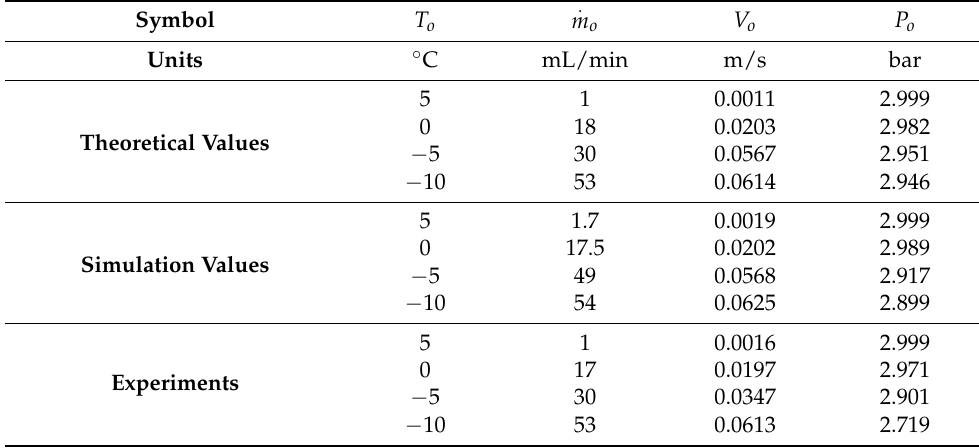
Table 4. Fluid characteristic values through the anti-freezing